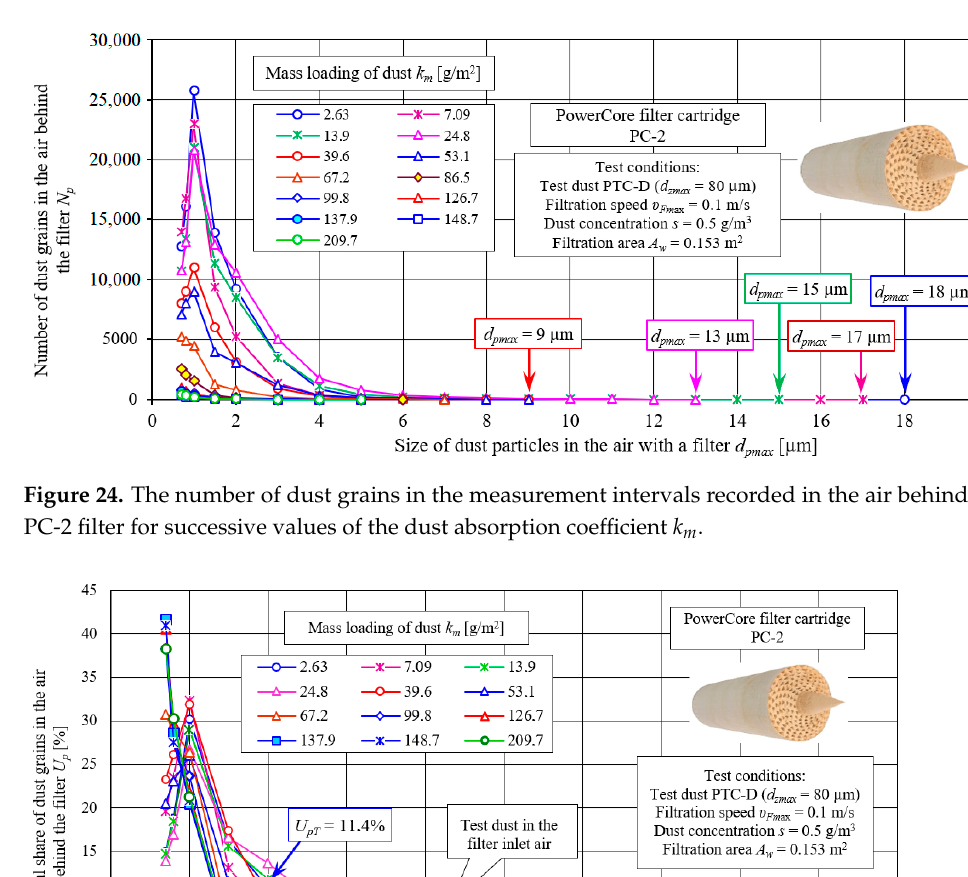
( d ) Figure 26. Granulometric composition of grains in the air behind the PC-2 filter after reaching suc- cessive values of dust absorption coefficients: ( a ) k mPC = 2.63 g/m 2 (measurement No. 1), ( b ) k mPC = 39.6 g/m 2 (measurement No. 5), ( c ) k mPC = 67.2 g/m 2 (measurement No. 7), ( d ) k mPC = 67.2 g/m 2 (meas- urement No. 16).